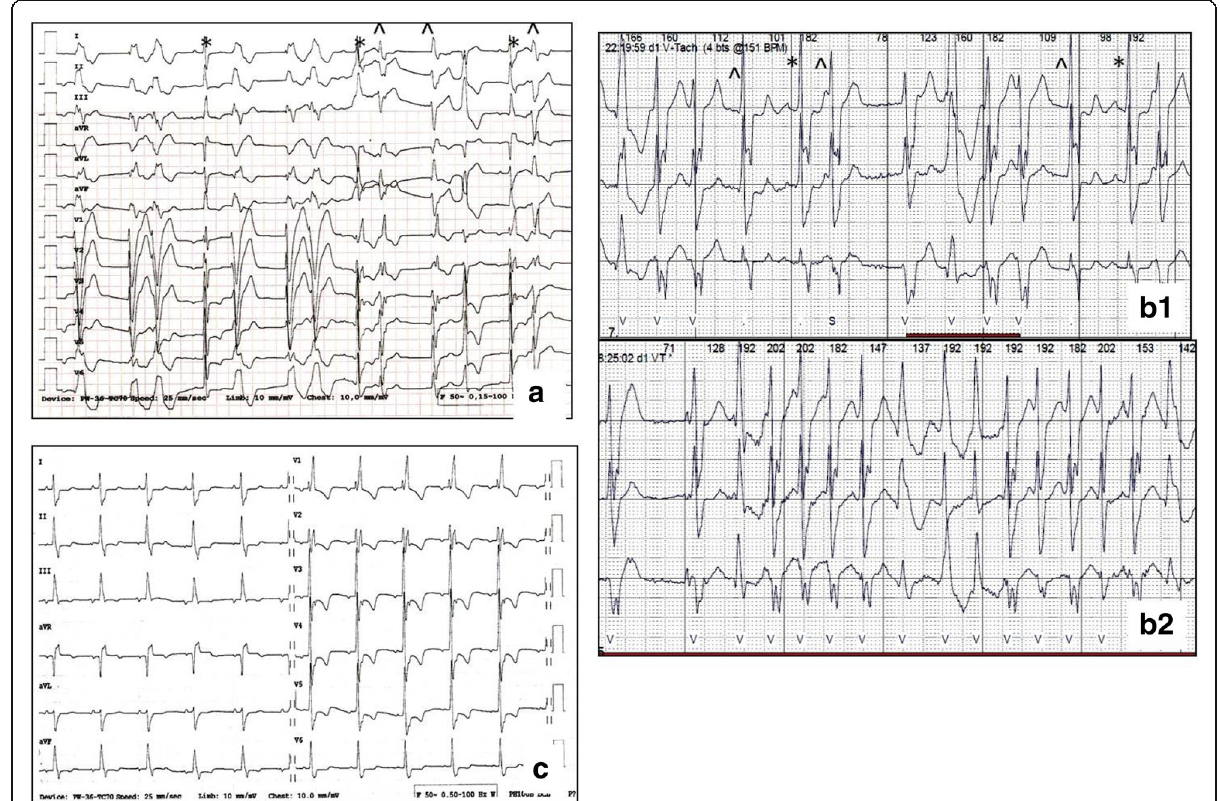
Fig. 2 Electrocardiograms before ( a , b ) and after ( c ) quinidine treatment. a representative 12-lead ECG before quinidine treatment (25 mm/sec., 10 mm/ mV), sinus beats (*) with different RBBB pattern, supraventricular and junctional beats (^) with RBBB+ LAH pattern, LBBB-like pattern ventricular extrabeats with variable saxis. b1, 2 24-h Holter ECG rhythm strip showed single sinus (*) and supraventricular (^) extrabeats and MPVCs with narrow QRS and different axis (upper panel) and nsVT (lower panel). c 12-lead ECG (25 mm/sec., 10 mm/mV) after quinidine treatment - morphology of P differed from sinus rhythm, RBBB with right axis, without ventricular arrhythmia. RBBB – right bundle branch block, LBBB - left bundle branch block, LAH – left anterior hemiblock, MPVCs - multifocal premature ventricular contractions, nsVT - non-sustained ventricular